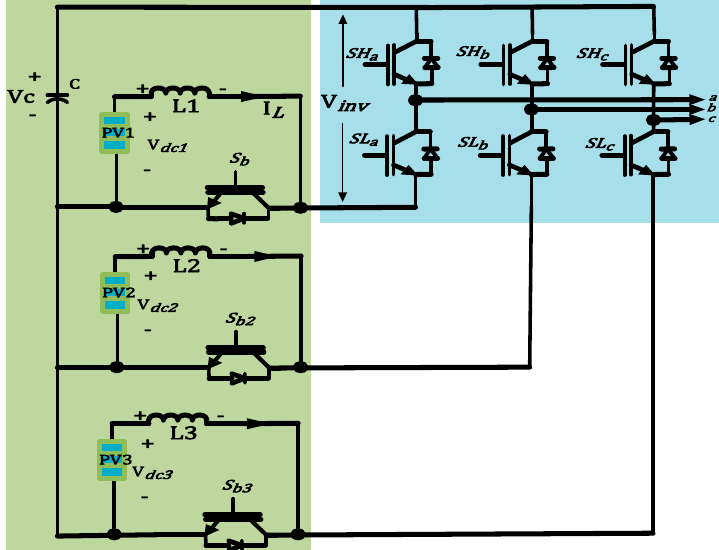
Figure 3. The proposed multi-input Ć uk-derived buck-boost inverter.